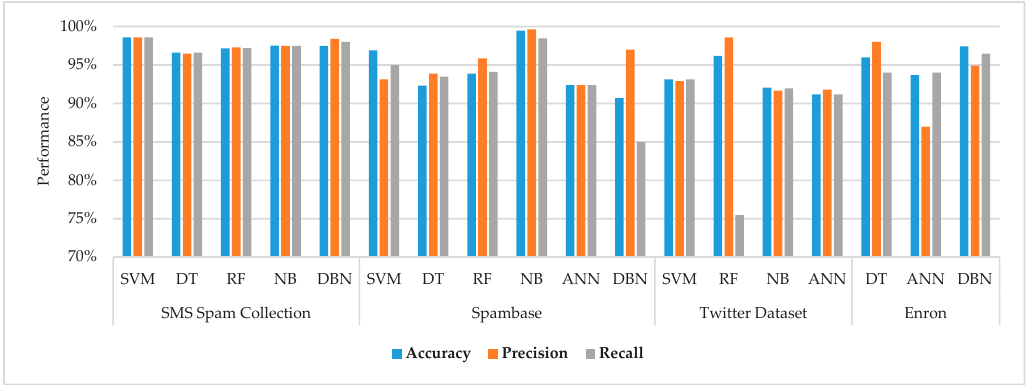
Figure 4. A comparative Analysis of Spam Detection using Machine Learning Techniques.